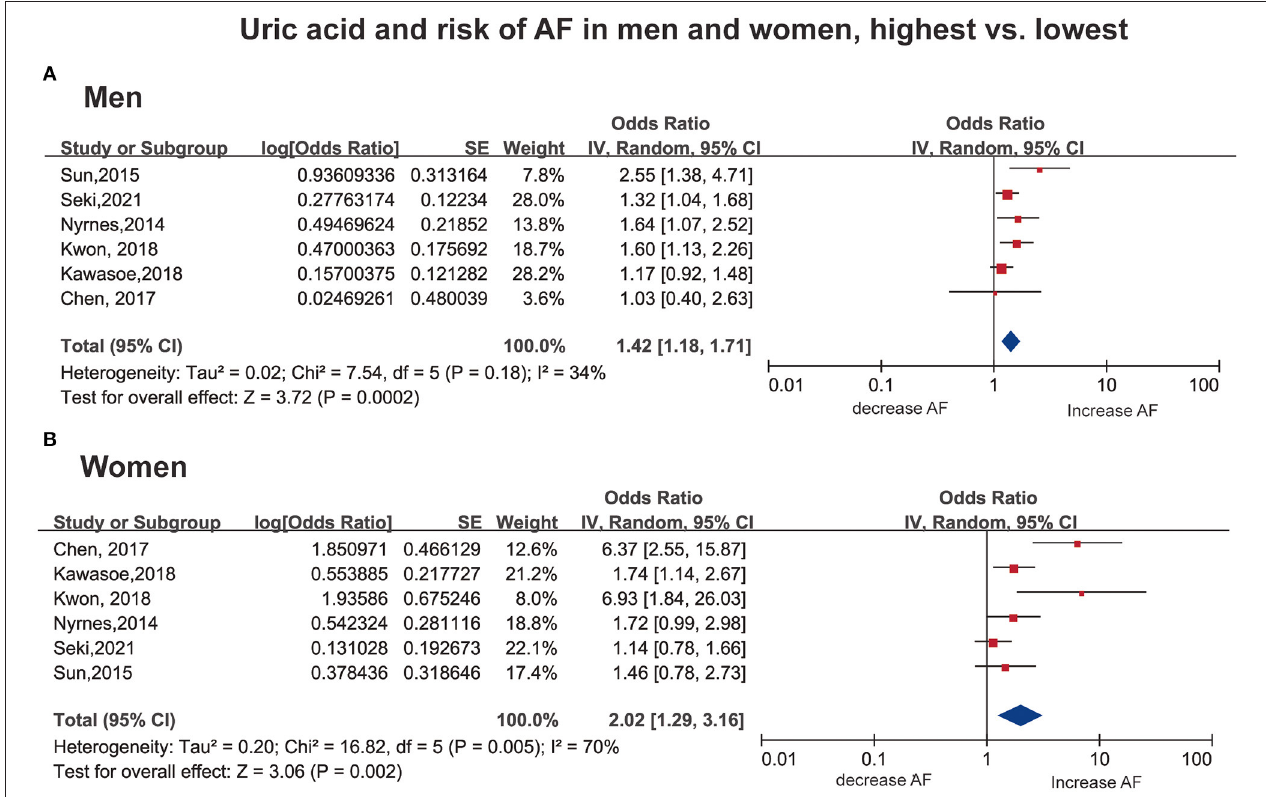
FIGURE 2 | Forest plot for the risk of AF with the highest vs. the lowest serum uric acid among men (A) and women (B) . AF, atrial fibrillation SE, standard error.